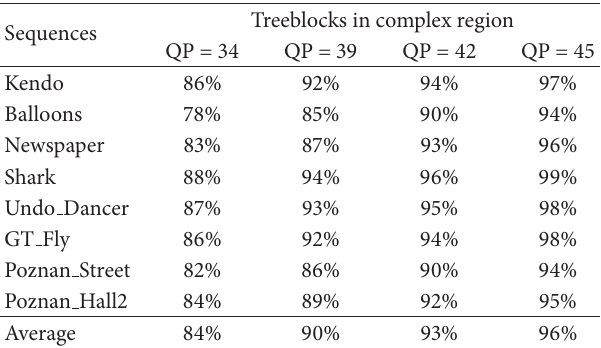
Table 5: Statistical analysis of accuracy for proposed